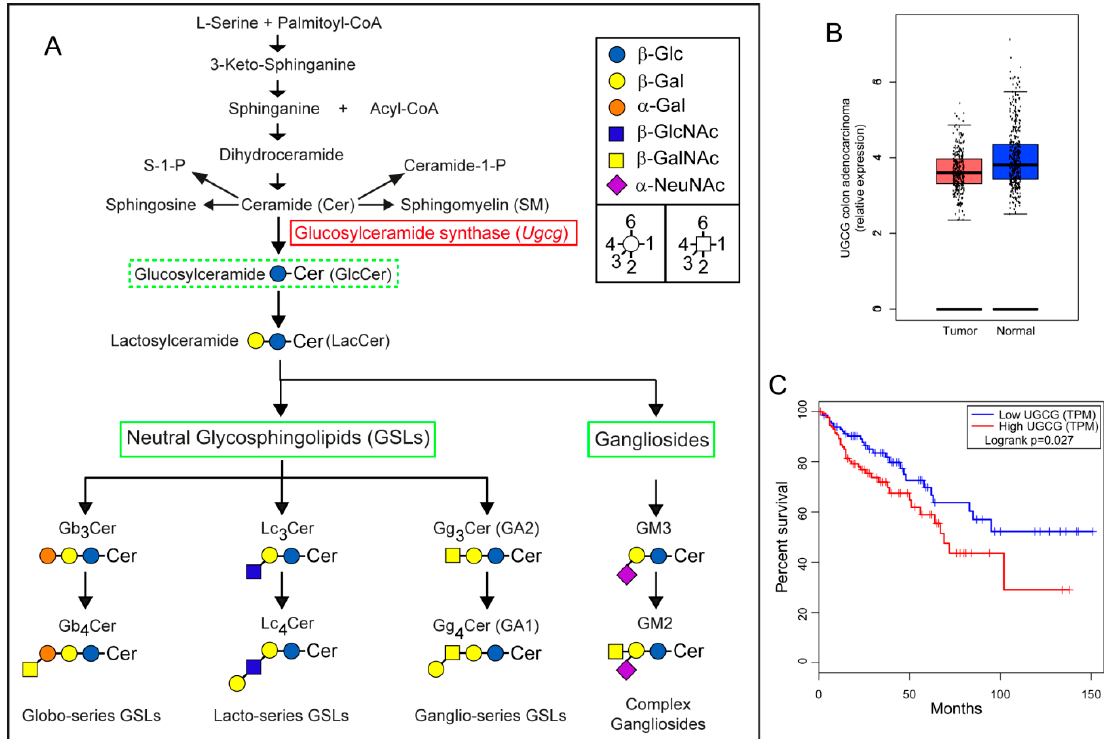
Figure 1. UGCG expression in human colorectal cancer (CRC) with relation to survival. ( A ) Sphingolipid synthesis pathway; the enzyme glucosylceramide synthase (GCS) encoded by the gene UGCG is the initial enzyme in the glycosphingolipid (GSL)-biosynthesis pathway. Targeting GCS using genetic approaches or with specific inhibitors such as Genz-123346 disrupts the synthesis of glucosylceramide (GlcCer) and its downstream GSL-products and may lead to accumulation of precursors. (GSLs are abbreviated according to the joint commission on biochemical nomenclature of glycolipids [23]). ( B ) The expression of UGCG mRNA was lower in human CRC as compared to normal colon. ( C ) However, patients with high UGCG mRNA expression in colorectal tumors had a reduced overall survival time than patients with lower UGCG expression.